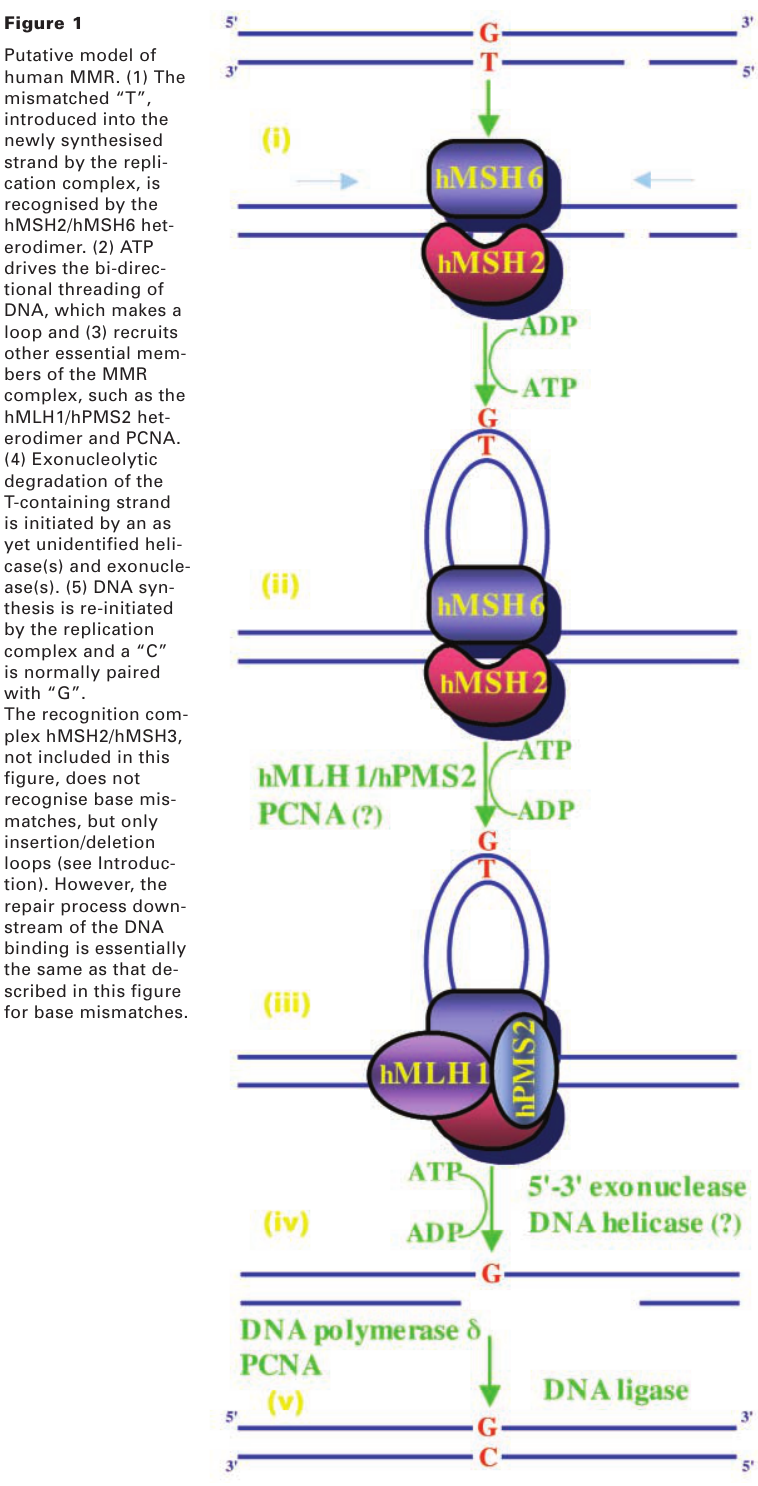
Putative model of human MMR. (1) The mismatched “T”, introduced into the newly synthesised strand by the repli- cation complex, is recognised by the hMSH2/hMSH6 het- erodimer. (2) ATP drives the bi-direc- tional threading of DNA, which makes a loop and (3) recruits other essential mem- bers of the MMR complex, such as the hMLH1/hPMS2 het- erodimer and PCNA. (4) Exonucleolytic degradation of the T-containing strand is initiated by an as yet unidentified heli- case(s) and exonucle- ase(s). (5) DNA syn- thesis is re-initiated by the replication complex and a “C” is normally paired with “G”. The recognition com- plex hMSH2/hMSH3, not included in this figure, does not recognise base mis- matches, but only insertion/deletion loops (see Introduc- tion). However, the repair process down- stream of the DNA binding is essentially the same as that de- scribed in this figure for base